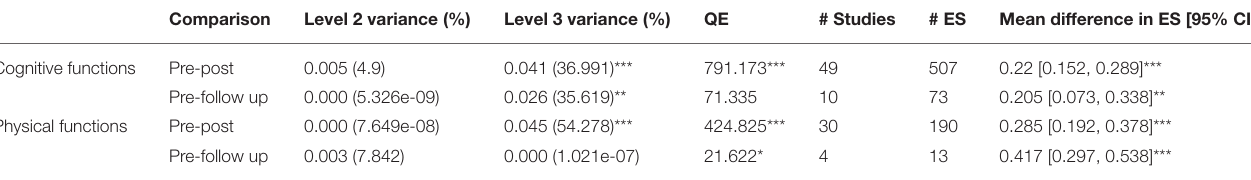
TABLE 2 | Summary effect of pre-post and pre-follow up comparisons of pooled cognitive and physical differences of effect sizes, respectively. Comparison Level 2 variance (%) Cognitive